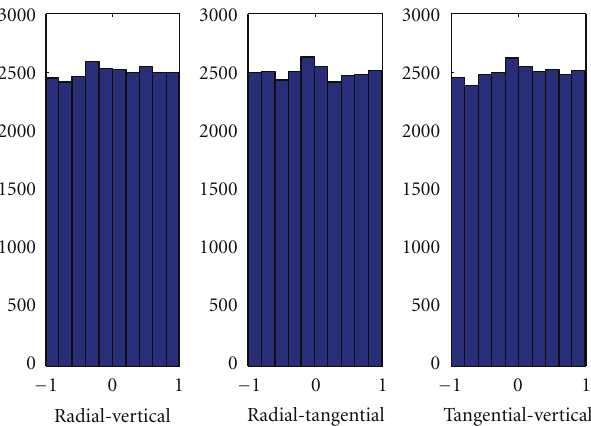
Figure 14: Histograms of anisotropy coe ffi cients for large chamber with dimensions D x = 3m, D y = 2m, and D z = 1 . 5m operating around 750 MHz.